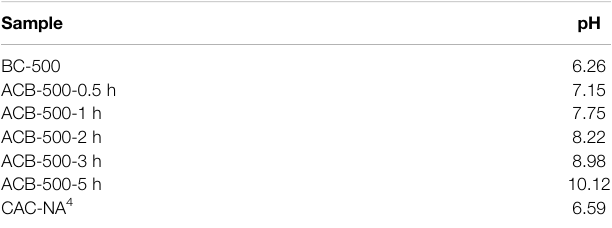
TABLE 7 | pH of water suspensions of bio-chars produced at 500 ° C, activated bio-chars produced at 900 ° C (different activation times changing from 0.5 to 5 h), and CAC.